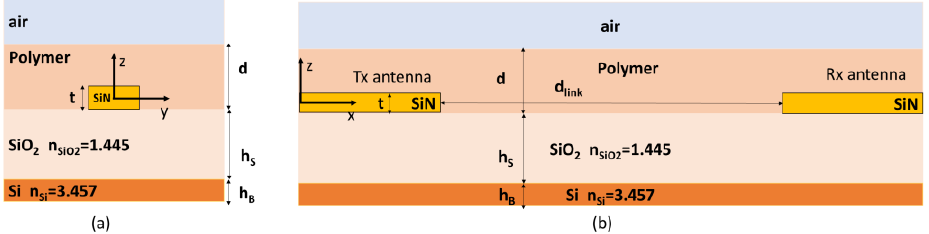
Figure 8. Scheme of the on-chip multilayered structure: ( a ) yz cross-section, and ( b ) xz